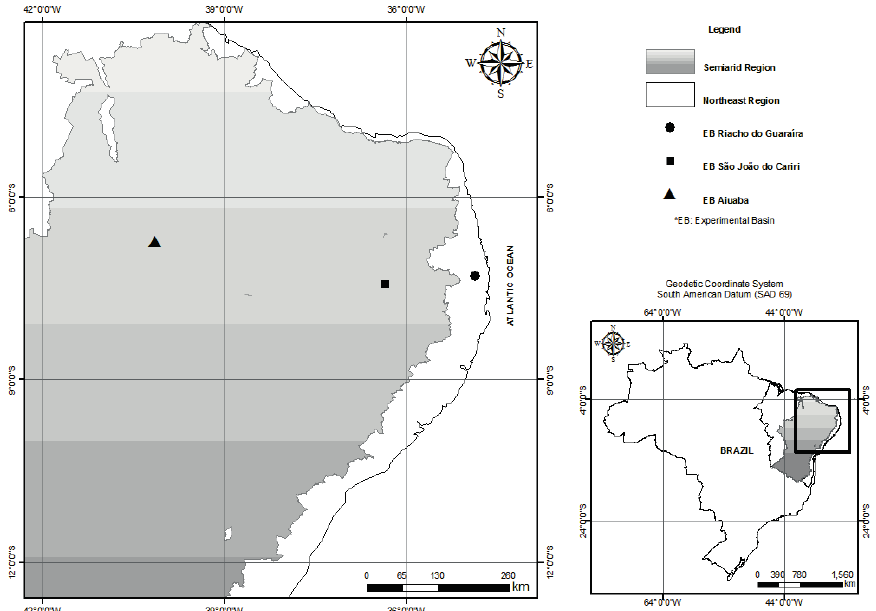
Fig. 1 Location of three experimental basins, where two of them are located to semi-arid region of